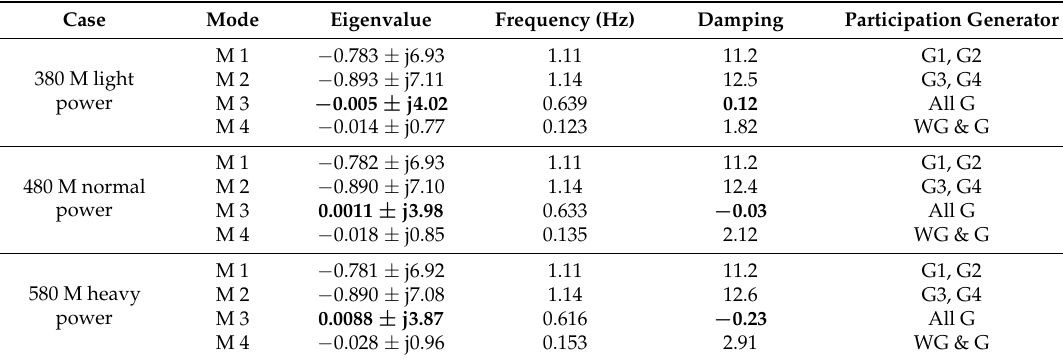
Table 1. The oscillation modes without PSS and